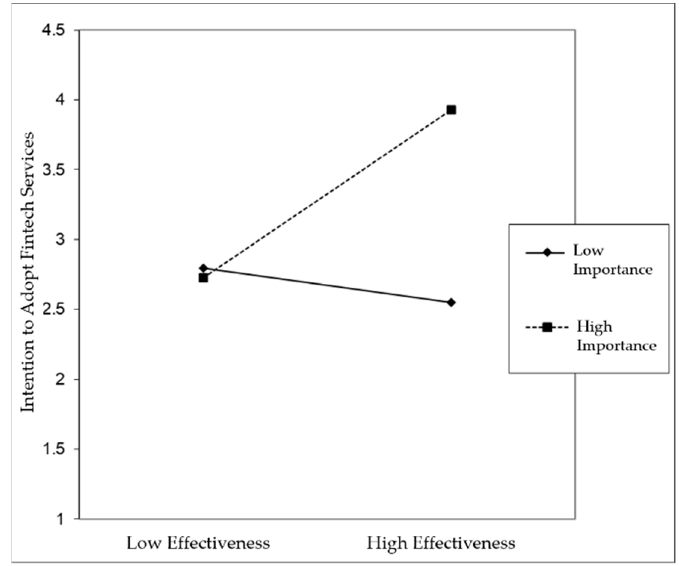
Figure 2. Interaction Importance of Characteristics of Fintech services to the firm × Perception of Effectiveness of Fintech services (Source: Microsoft Excel 365).